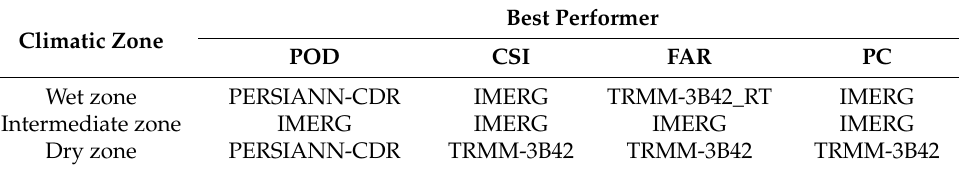
Table 6. Best performing SRPs in terms of Cis. Climatic Zone